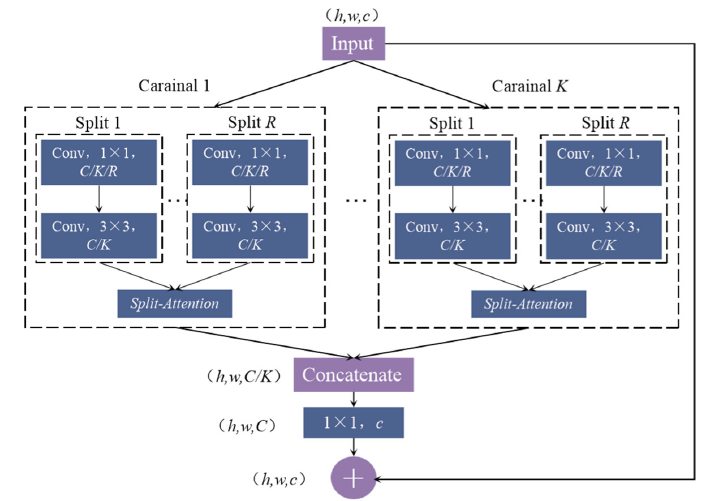
Figure 2. ResNeSt structure.